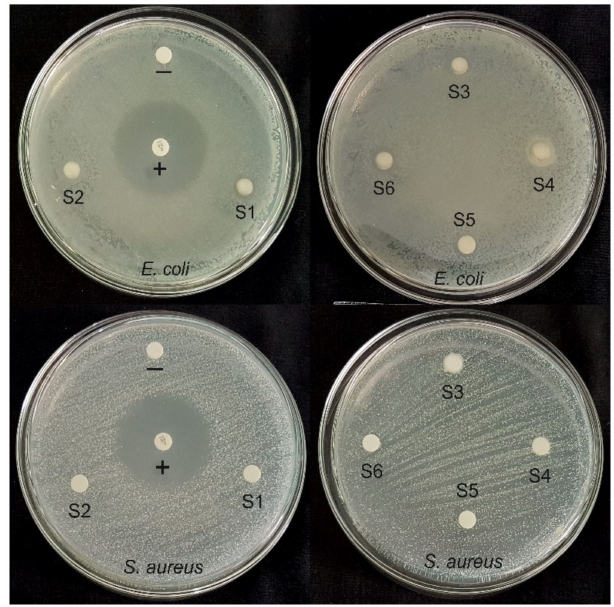
Figure 6. Zone of inhibition (ZOI): control positive (+); control negative (–); Ti-HA composites (S1–S6) against bacteria ( E. coli and S. aureus ).